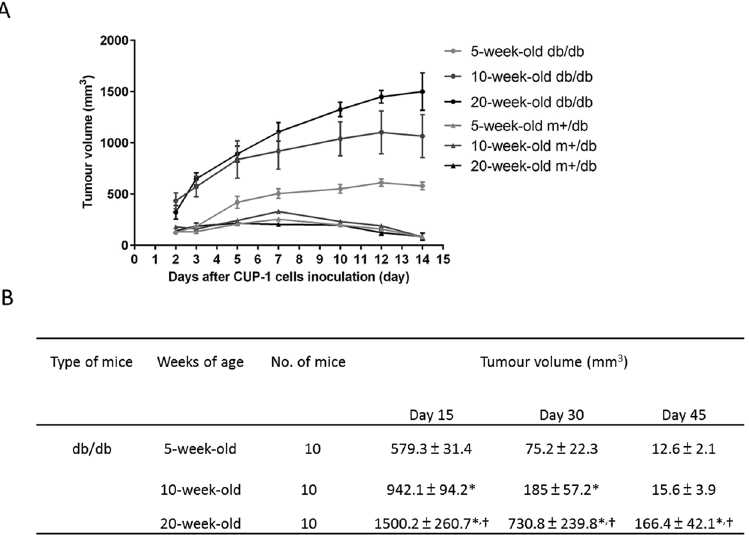
Figure 1. Tumorigenicity of CUP-1 tumor cell line in vivo . ( A ) The growth of CUP-1 cells, as tumor allografts in 5-, 10- and 20-week-old db/db and db/m + control mice. After 2 × 10 7 CUP-1 cells were injected subcutaneously into the scruff of mice, the short and long diameters of the tumors were measured weekly and tumor volumes (mm 3 ) were calculated. Each point represents the mean ± S.E.M (n = 10). ** p < 0.01, diabetic group compared to the control group. ( B ) The growth of 2 × 10 7 CUP-1 allografts in 5-, 10- and 20-week-old db/ db mice. * p < 0.05 compared to the corresponding 5-week-old group † p < 0.05 compared to the corresponding 10-week-old group. Each point represents mean ± S.E.M (n =